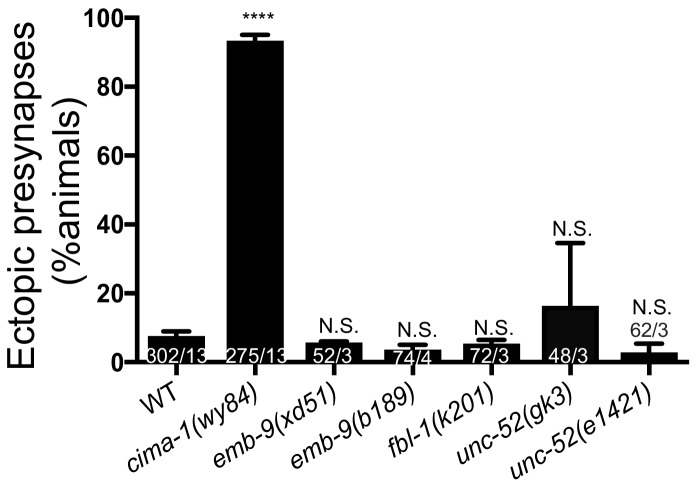
Phenotypes in AIY synapses of alleles affecting basement membrane proteins.Quantification of the percentage of adult animals with ectopic synapses in the AIY Zone 1 region in wild type (WT), cima-1(wy84), emb-9(xd51), emb-9(b189), fbl-1(k201), unc-52(gk3) and unc-52(e1421) mutants. In the graph, the total number of animals (N) and the number of times scored (n) are indicated in each bar for each genotype as N/n. Statistical analyses are based on one-way ANOVA by Tukey’s multiple comparison test. Error bars represent SEM. NS: not significant or p>0.05.